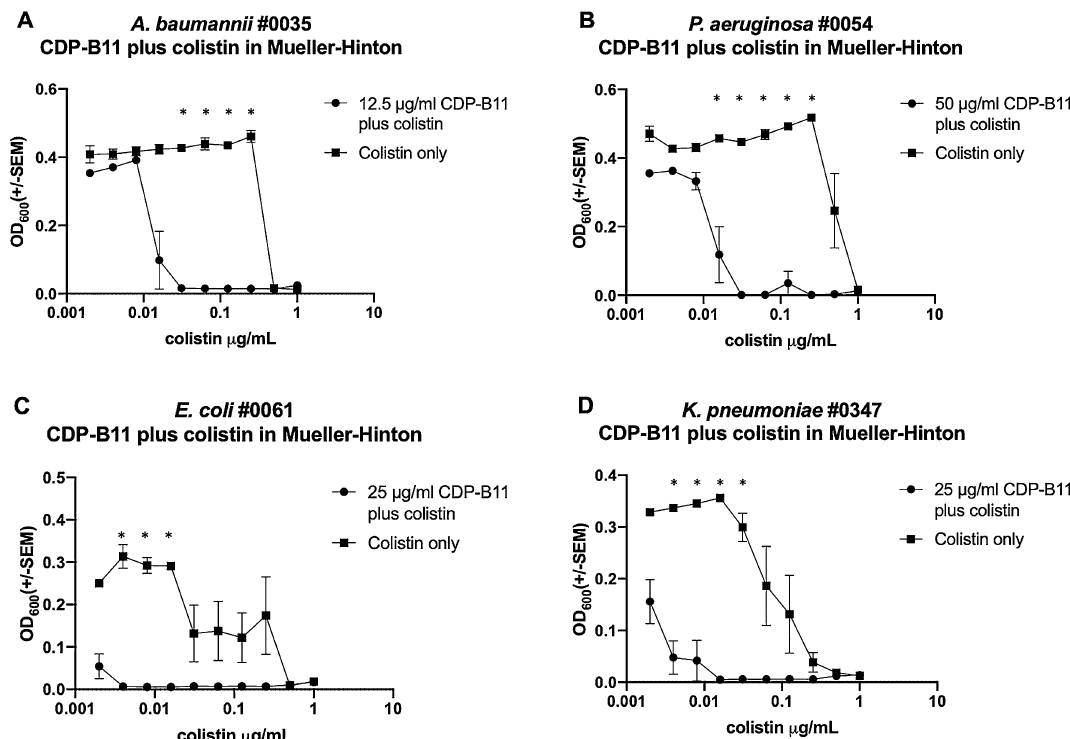
Figure 4. Optical density (600 nm) after 24 h culture for A. baumannii #0035 ( A ), P. aeruginosa #0054 ( B ), E. coli #0061 ( C ), and K. pneumoniae #0347 ( D ) with both CDP-B11 and colistin in Mueller–Hinton media. Circles represent colistin concentration with a fixed concentration of CDP-B11. Squares represent cultures treated with colistin only. Statistical comparisons were performed with the corresponding Holm–Sidak method and α ≤ 0.05, without assuming a consistent standard